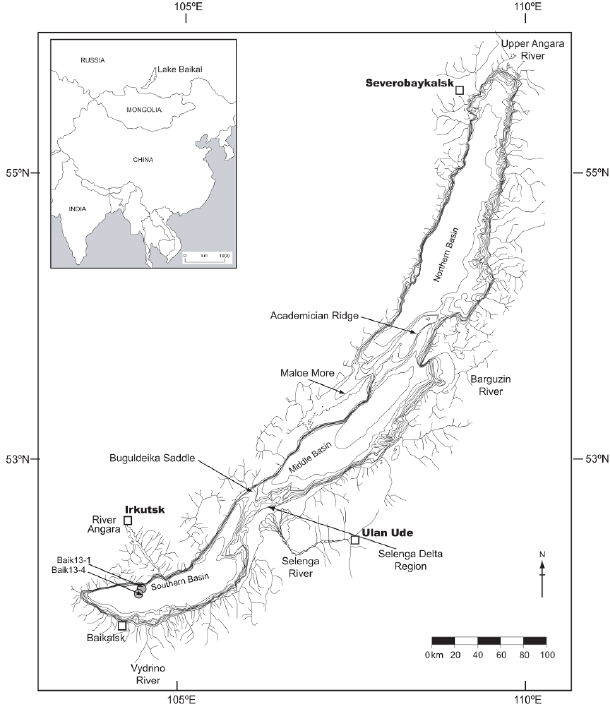
Figure 1. Map of the Lake Baikal catchment, showing dominant inflowing rivers and the Angara River outflow. The three catch- ments are identified as well as the location of sites BAIK13-1 and BAIK13-4, where cores, sediment traps and water column profiles were